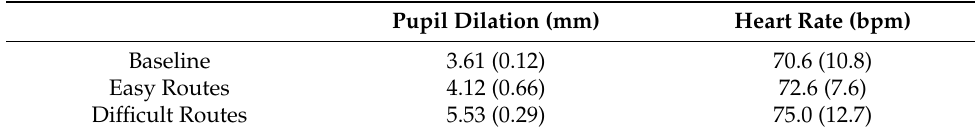
Table 2. Average Physiological Response